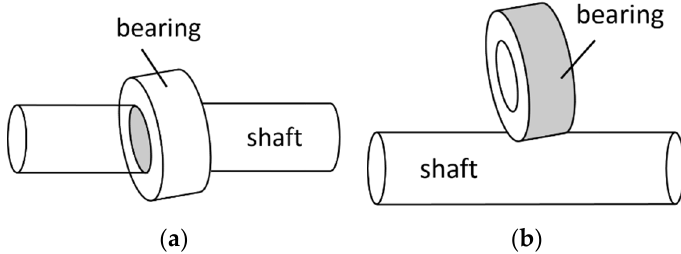
Figure 1. Threadless ball screw (TLBS) design types: ( a ) Bearings contact with the shaft via internal edges; ( b ) Bearings contact with the shaft via external edges.